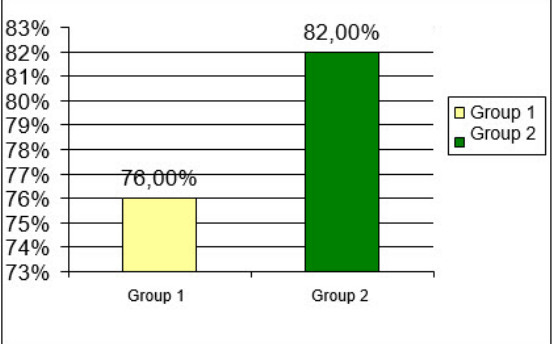
Figure 6. Success level of pictures col- lecting by preschool